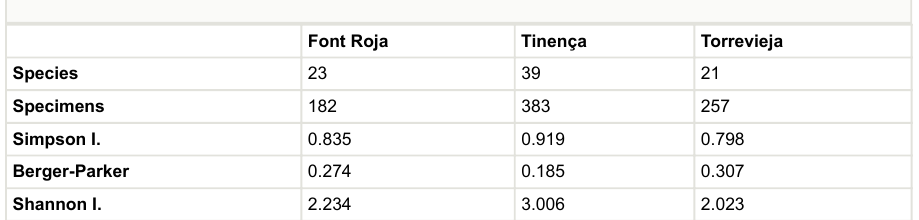
Expected frequency of species (exp f) according to abundance models (log-series, log-normal and broken-stick) for the Aspilota -group